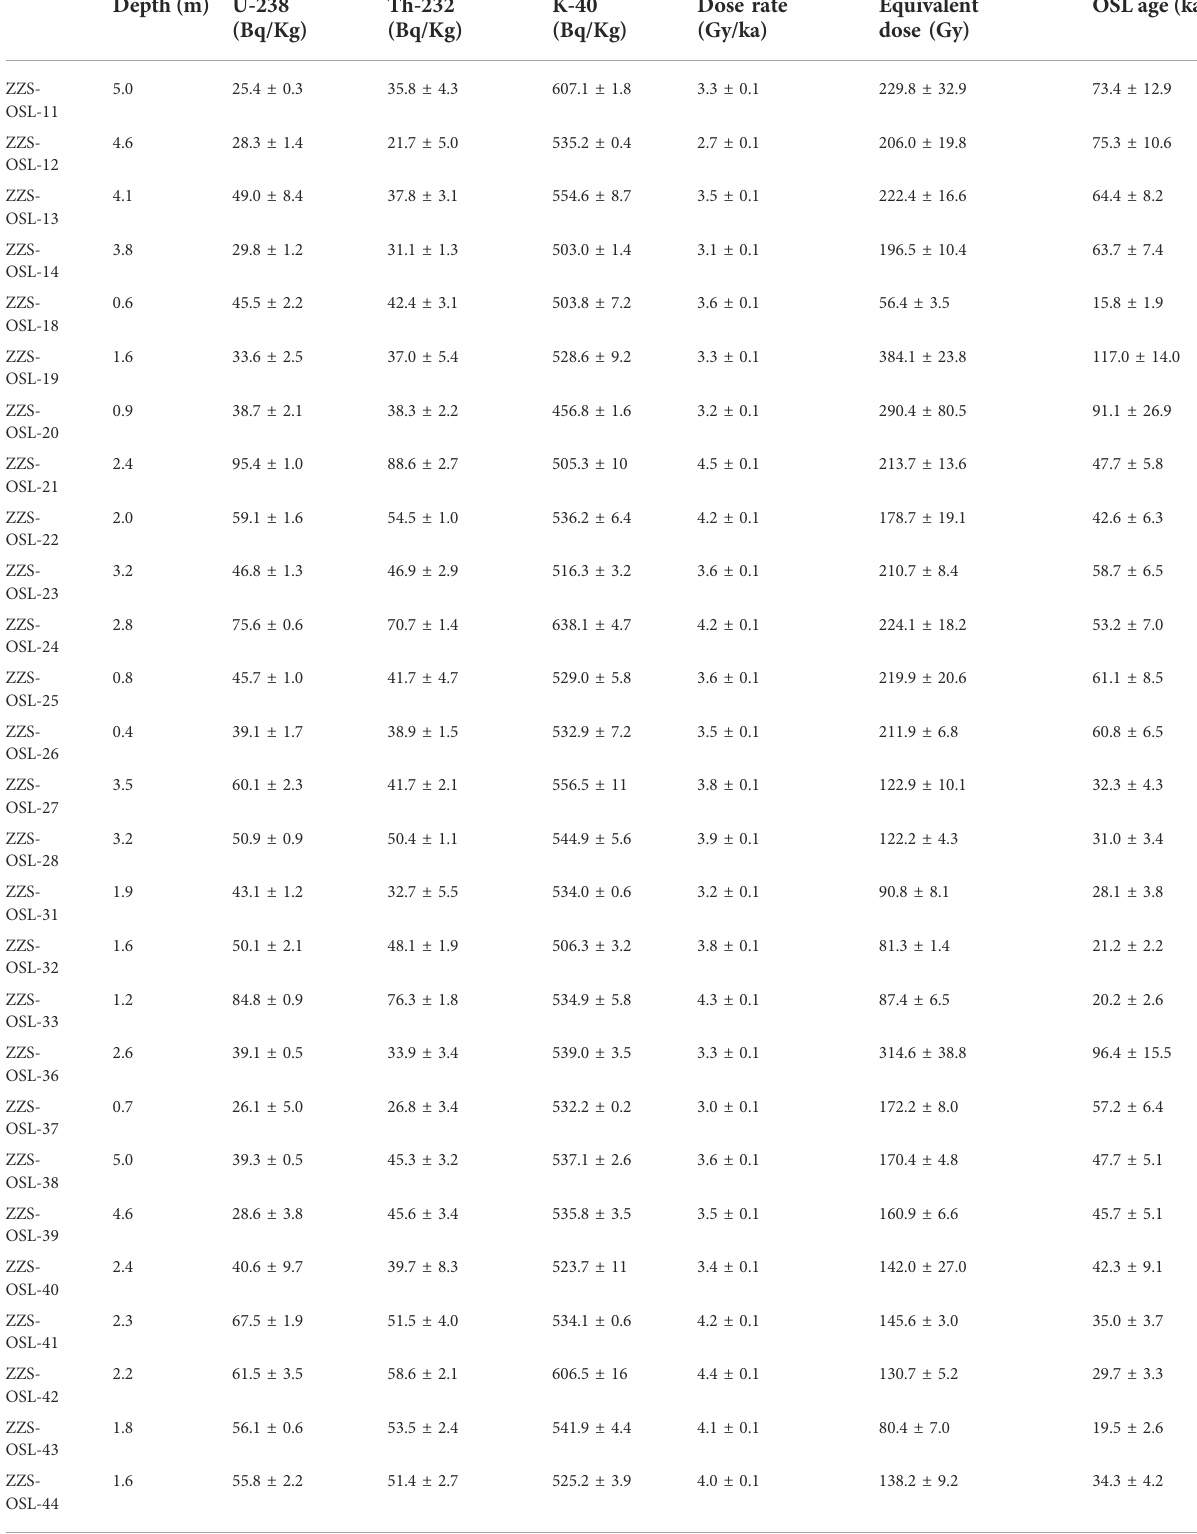
TABLE 1 Result of OSL analysis for the layers in the